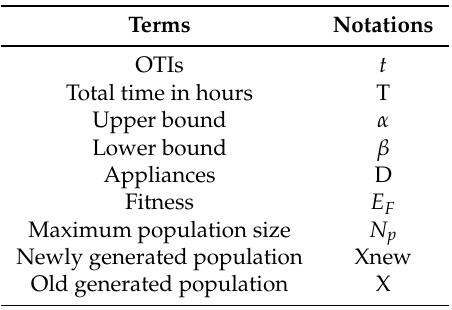
Table 4. Terms used in hybrid bacterial flower pollination algorithm and their